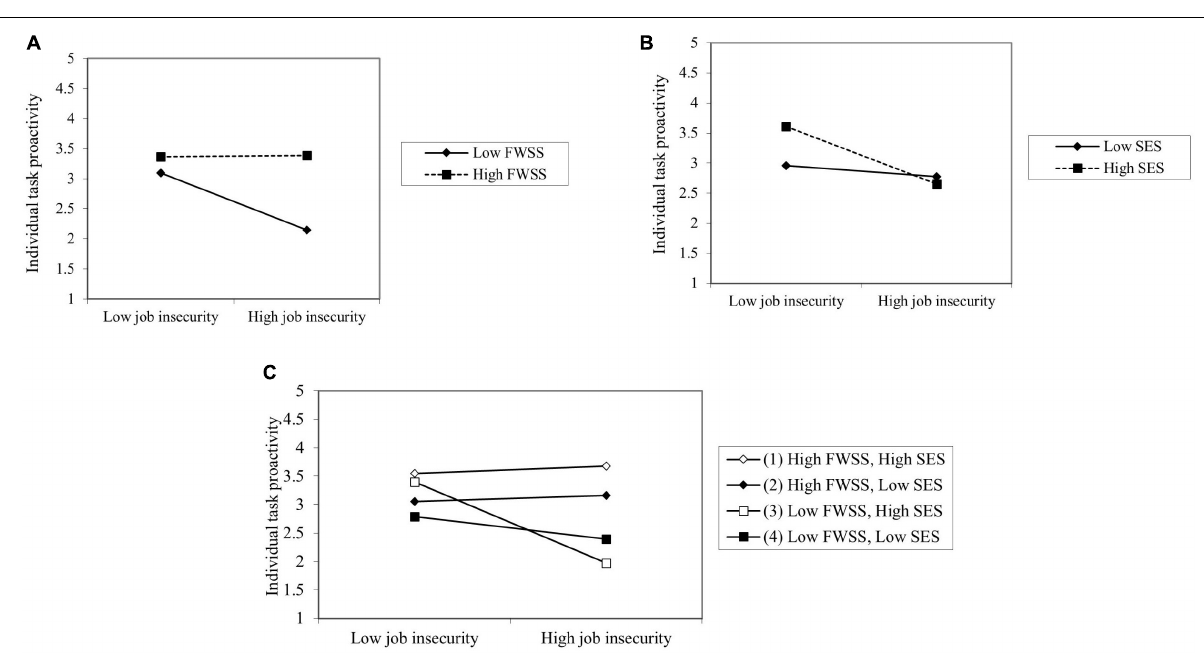
FIGURE 3 | The moderating role of FWSS and SES on the relationship between job insecurity and ITP. (A,B) Two-way interaction. (C) Three-way